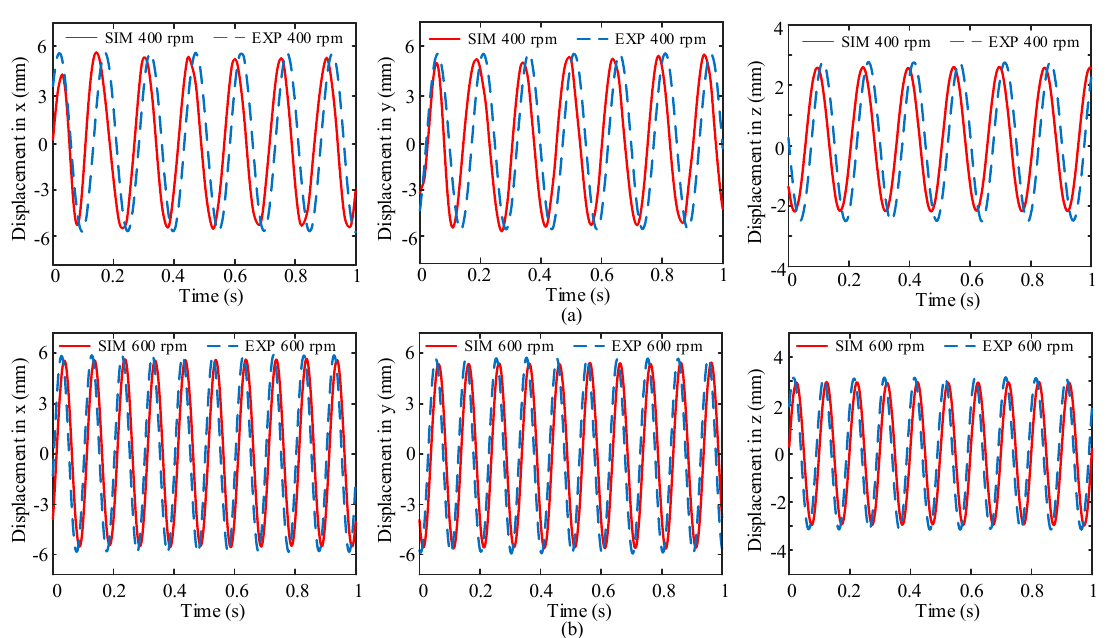
Figure 16. Comparison of the displacements in the x-, y-, and z-directions between simulation and experiment for ( a ) 400 rpm and ( b ) 600 rpm.